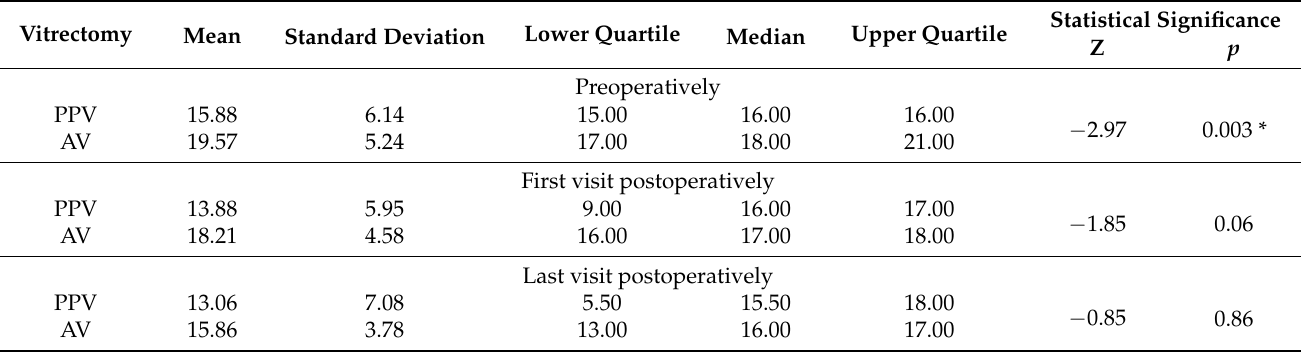
Table 5. Changes in intraocular pressure before and after